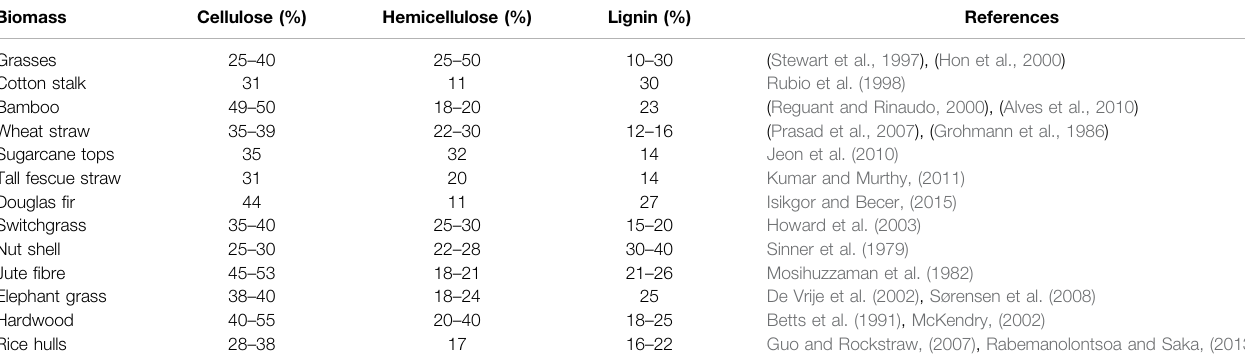
TABLE 1 | Composition of selected lignocellulosic